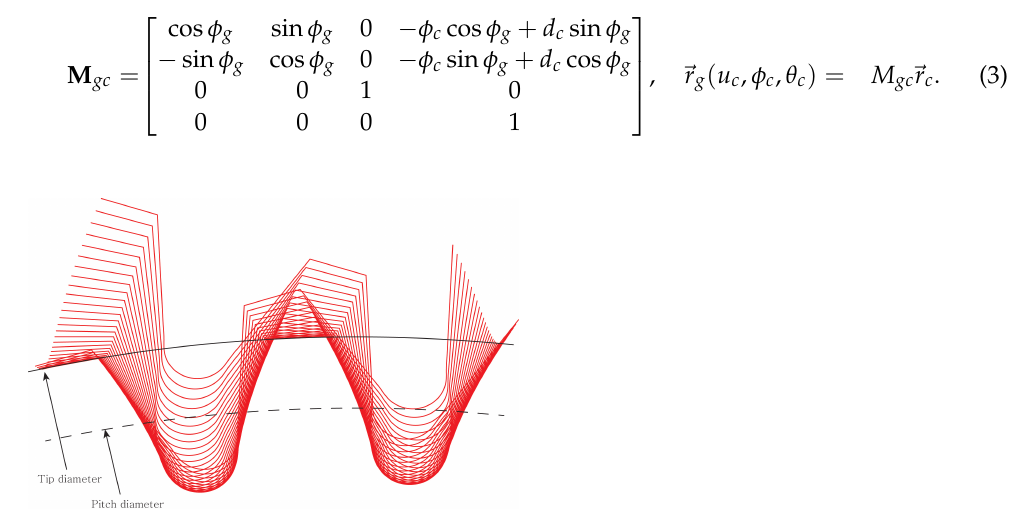
Figure 2. Family of rack cutter